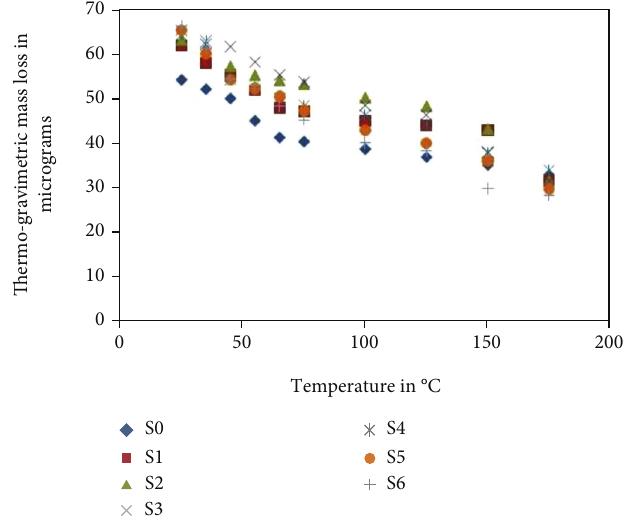
Figure 5: Mass loss during thermal adsorption e ff ect of PSU